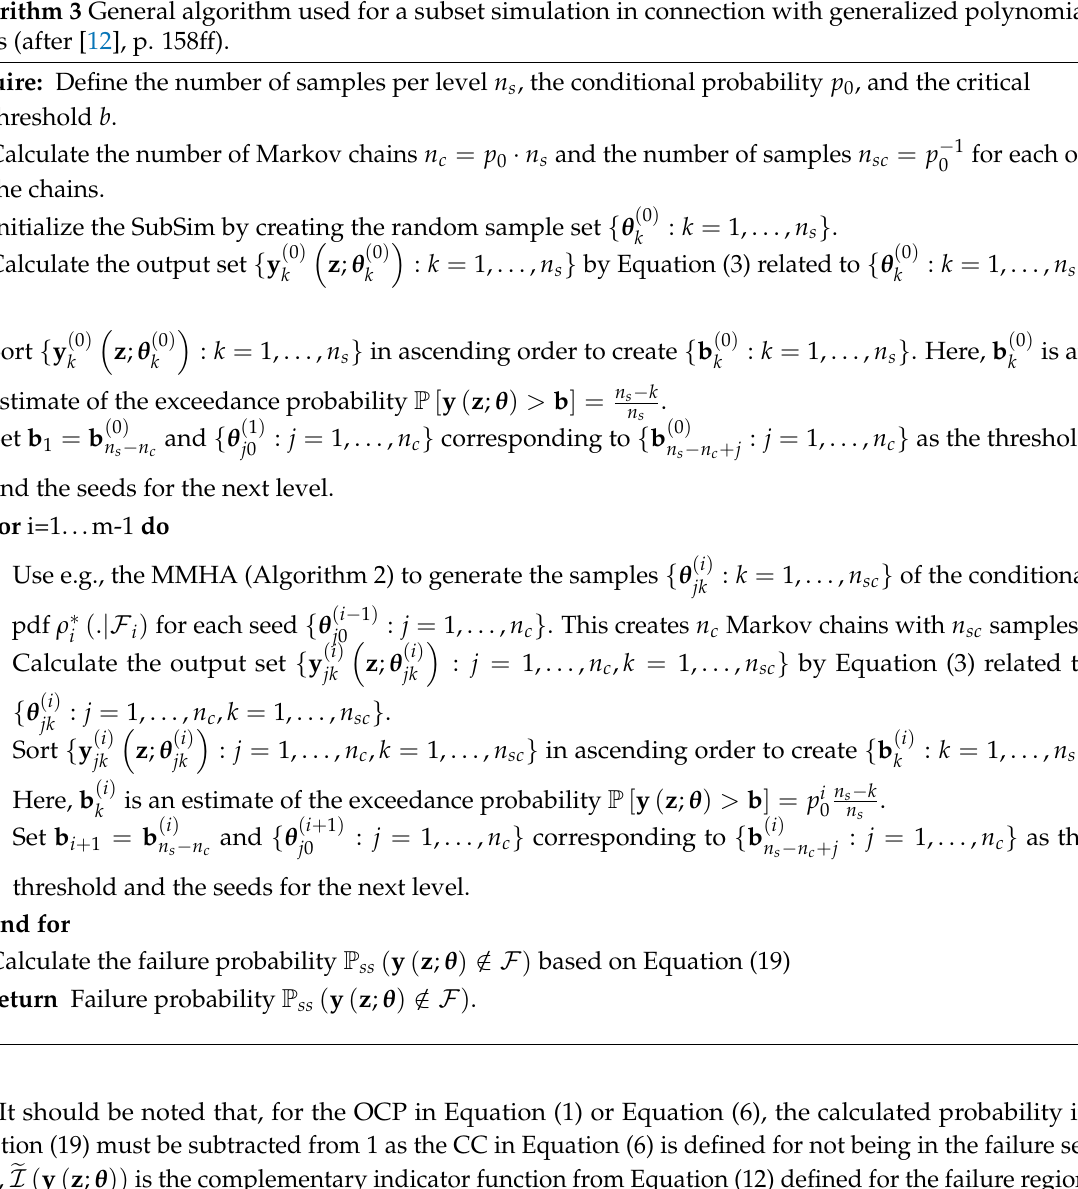
Algorithm 3 General algorithm used for a subset simulation in connection with generalized polynomial chaos (after [12], p.